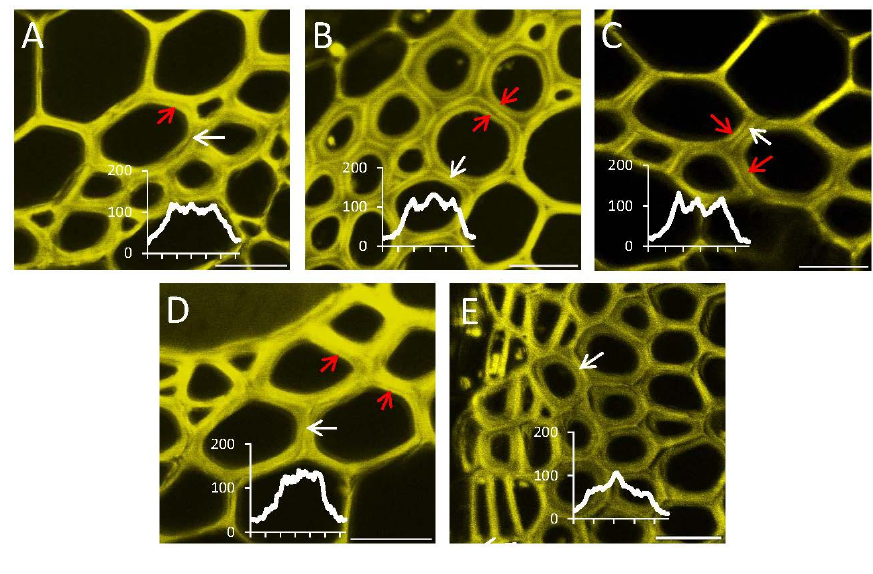
Figure 4. Distribution of signals from different glycoside hydrolase activities in the cell walls of interfascicular fibers in Arabidopsis stems. ( A ) Glc-β-Res; ( B ) Glc-Glc-β-Res; ( C ) Glc- S -Glc-β-Res; ( D ) Gal-β-Res; ( E ) XXXG-β-Res. All reactions were carried out in optimal conditions (Table 1). The yellow fluorescence channel with resorufin signals is shown. Signals from the compound middle lamella are shown with the white arrows, and signals from the recently formed secondary wall layers are shown with red arrows. Intensity profiles through the cell wall area, shown by the white arrows, are included to visualize the labeling patterns in the cell wall better. Bar = 50